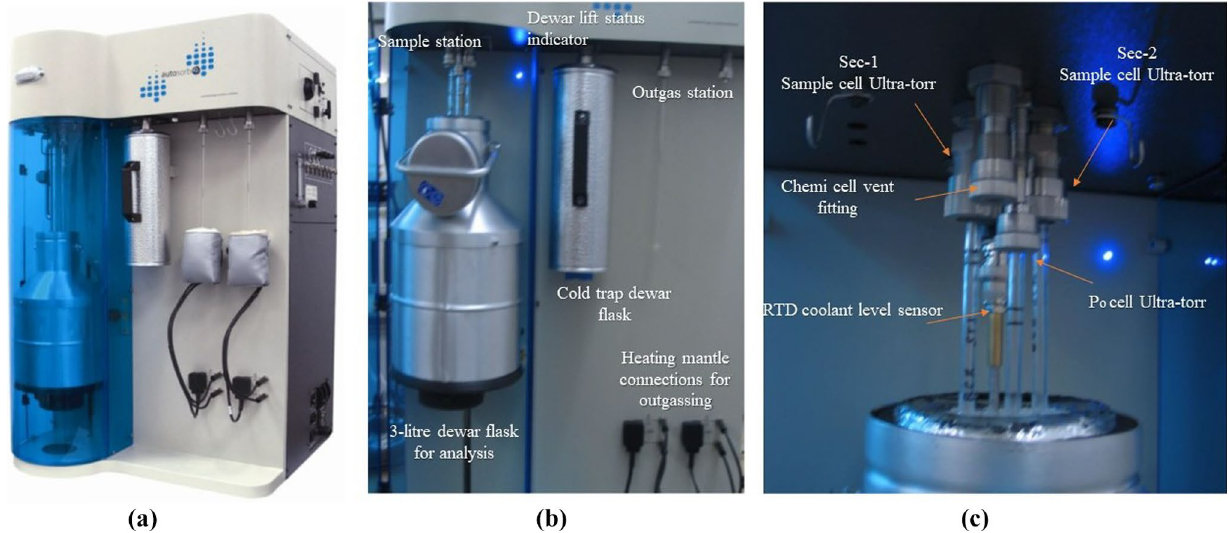
Fig. 1 a Quanta chrome instrument main body; b Front panel; c Analysis